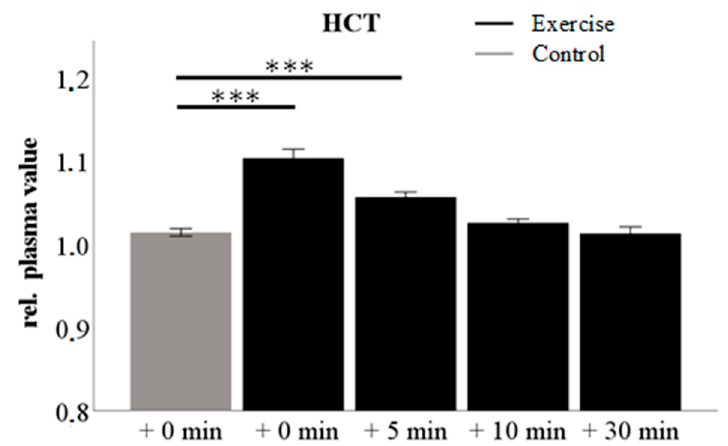
Figure 3. Relative changes in hematocrit compared to baseline in control (grey) and exercise intervention (black) at different time points in the early post-exercise period; *** p < 0.001 in comparison to the control intervention.